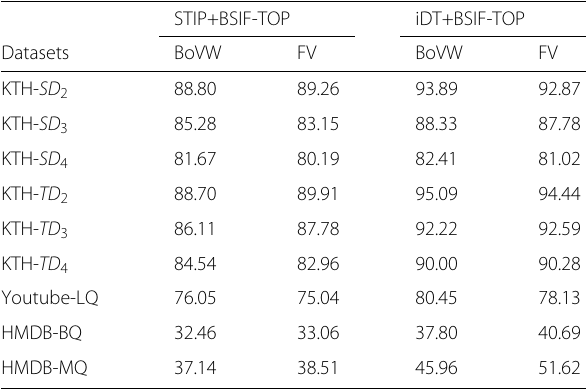
Table 5 Recognition accuracy (%) of various datasets with STIP+BSIF-TOP and iDT+BSIF-TOP methods usingbag-of-visual-words (BoVW) and fisher vector (FV) encoding